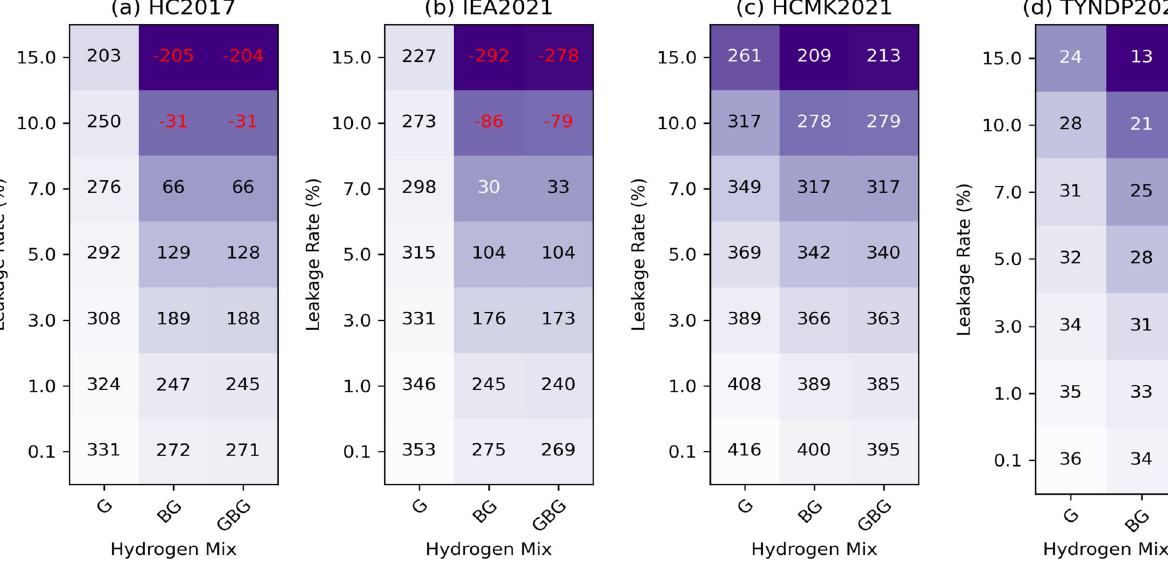
Fig. 6 Abatement of CO 2 emissions calculated based on the CGTP metric. Cumulative CO 2 equivalent emissions (GtCO 2 e) abatement over the 2030 – 2100 period associated with a hydrogen economy as a function of hydrogen leakage rate. The CO 2 equivalent emissions are calculated based on the CGTP for four scenarios: ( a ) HC2017, ( b ) IEA2021, ( c ) HCMK2021, and ( d ) TYNDP2022. The emission abatement is calculated assuming three hydrogen portfolio: (G) green hydrogen supply only, (BG) a mix of blue + green hydrogen, and (GBG) a mix of grey + blue + green hydrogen. The net climate penalty conditions (negative emissions) are provided in